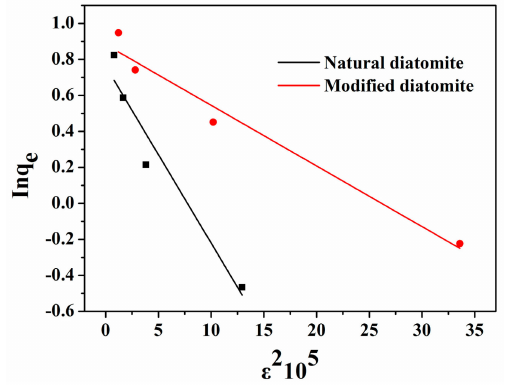
Figure 10. Diatomite adsorption 1-naphthol of D-R isotherm plots. Black: raw diatomite; Red: calcined 450 ◦ C